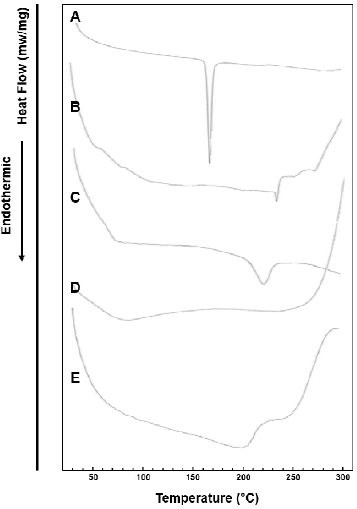
Figure 6. Differential scanning calorimetry (DSC) thermograms of ( A ) pure CLC, ( B ) PC, ( C ) Neusilin ® US2, ( D ) CCS, and ( E ) F11.